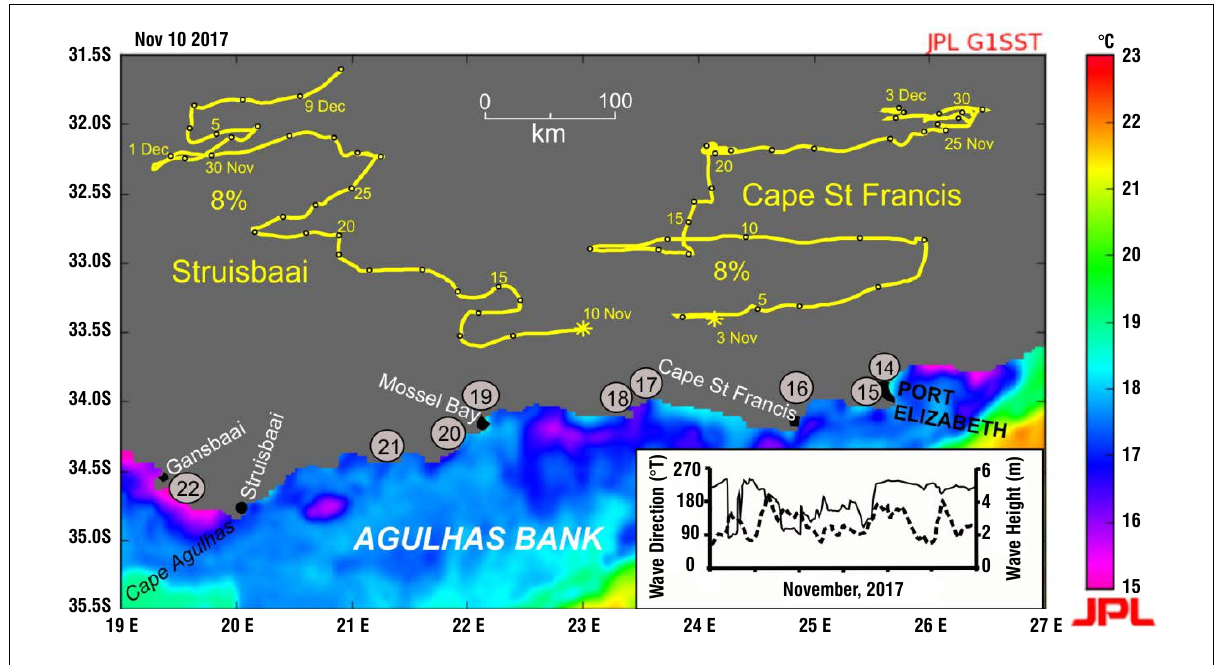
Figure 4: A satellite image for 28 October 2017, depicting sea surface temperatures (scale on right) off the Eastern Cape coast. The warm waters of the Agulhas Current are readily apparent, together with calculated geostrophic currents. The different sites where nurdles were reported are shown (Table 1), while various progressive vector diagrams with relevant weather stations are given together with day starts indicated by circles and day numbers in October and November. In the bottom right-hand corner, the hindcast wave direction and height (dotted) are given for 33.5°S and 28.5°E.